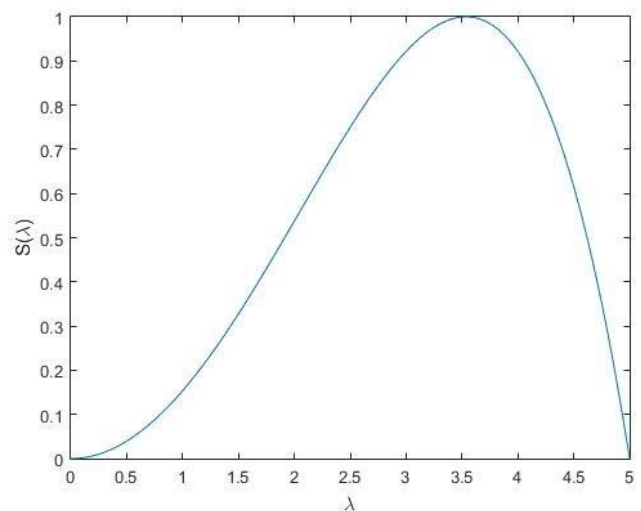
Figure 2. Theoretical spectral response used for